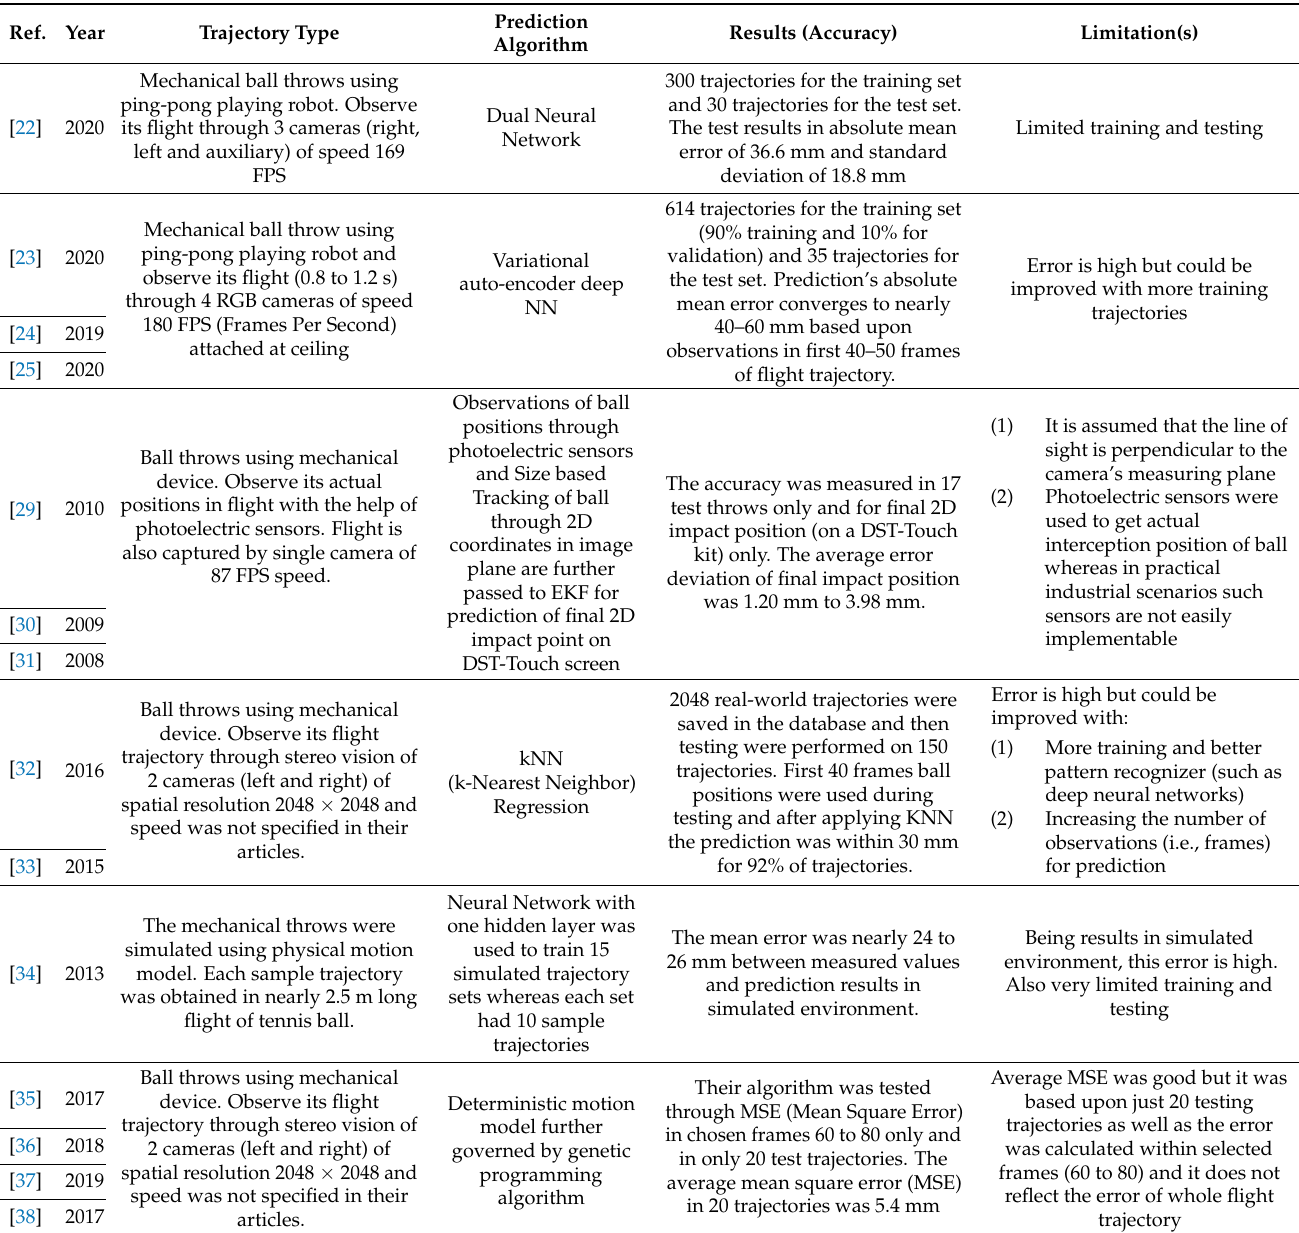
Table 1. Limitations in existing work of mechanically thrown objects